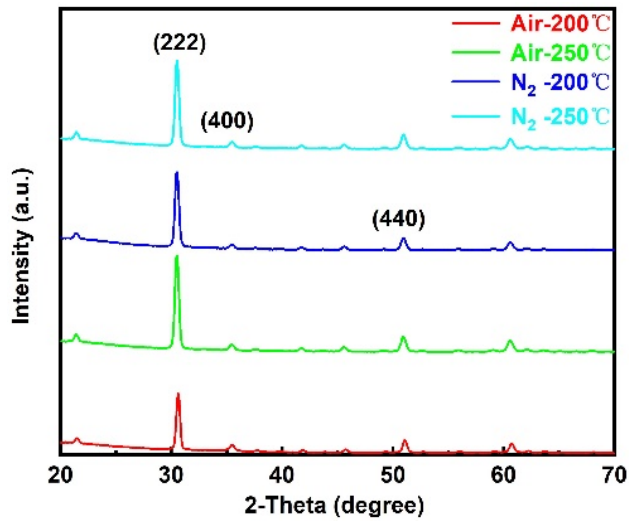
Figure 5. XRD patterns of In 2 O 3 :H films annealed in nitrogen and air atmosphere.